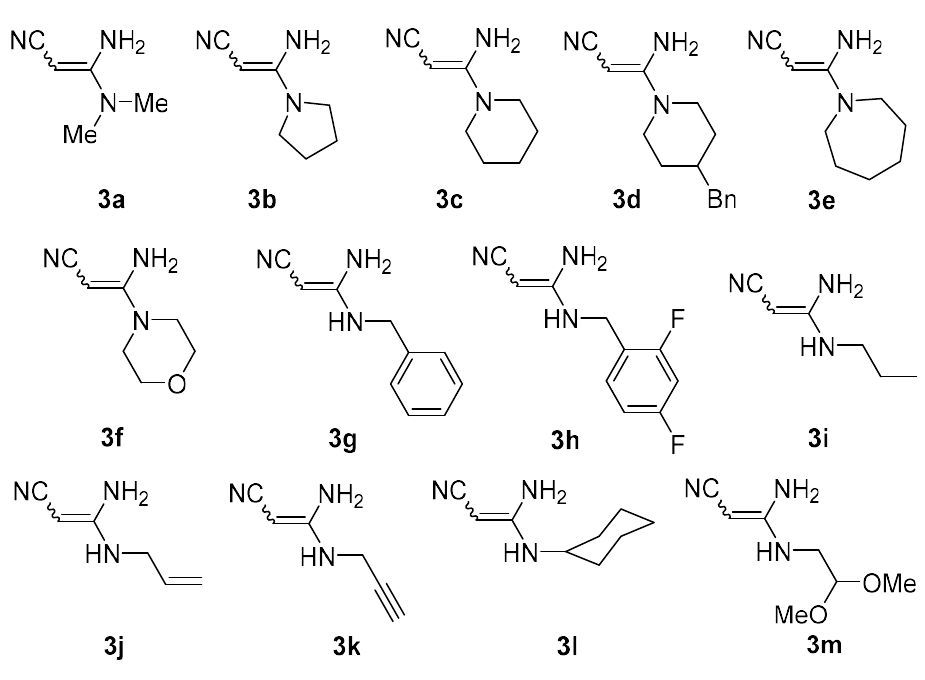
Figure 1. Structures of Starting Materials 3